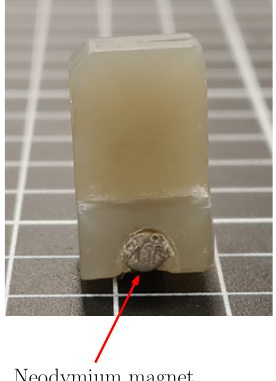
Figure 12. Lateral view from the linear shaft. The placement of the neodymium magnet allows it to be on the same height as the magnetic sensor